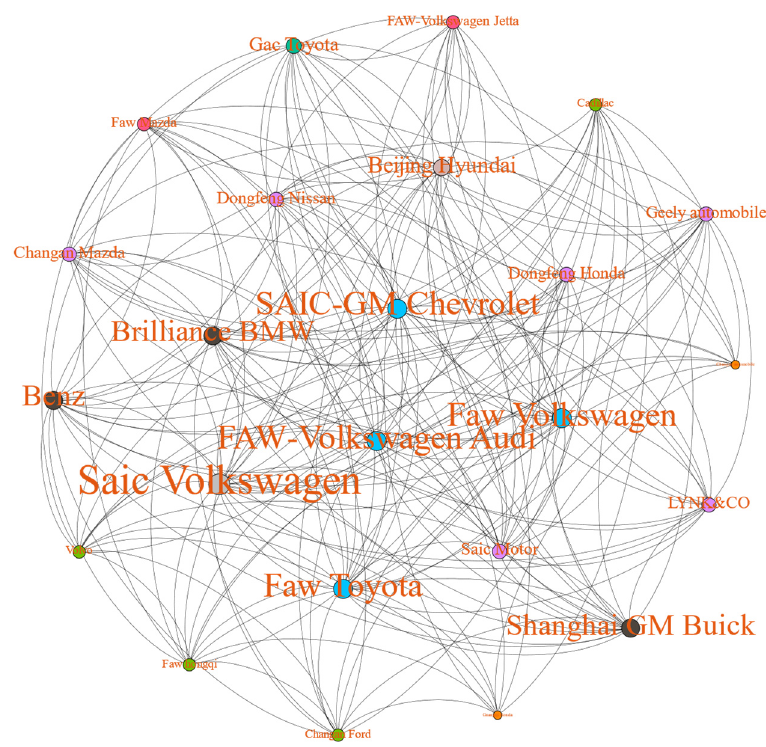
Figure A1. Competitive network.